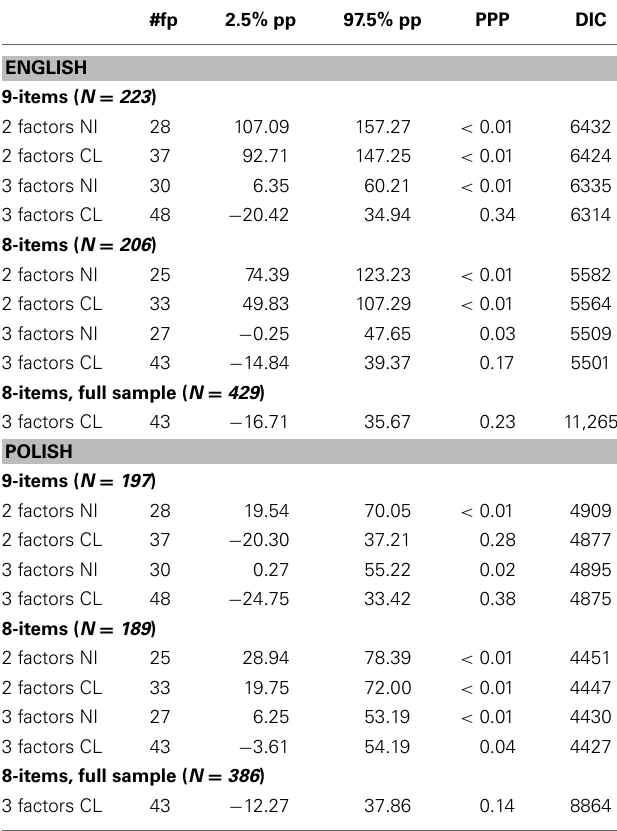
Table 2 | The confirmatory factor analyses using Bayesian